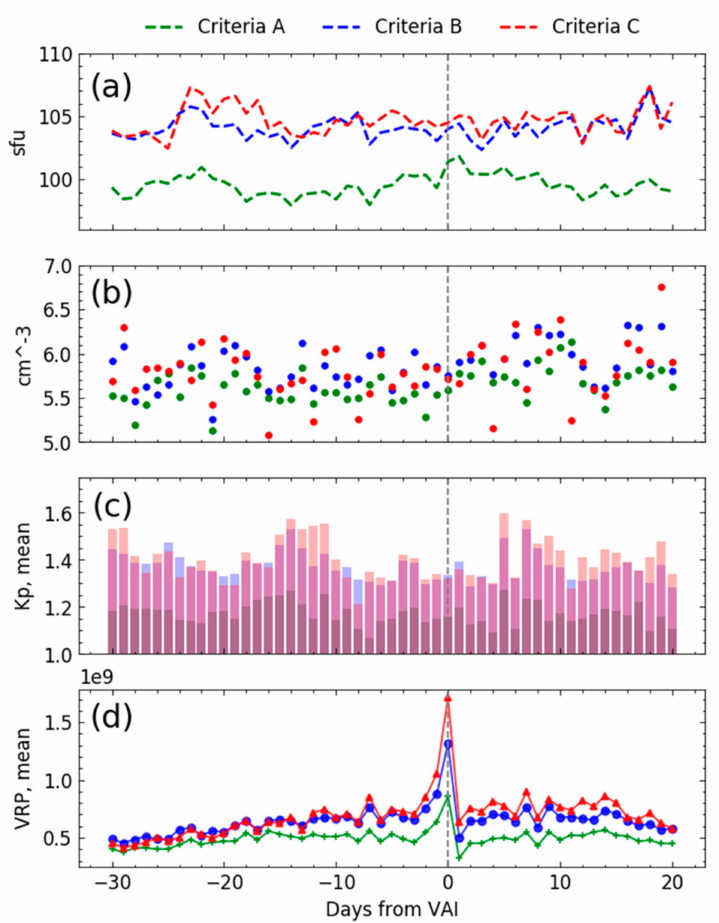
Figure 12. Mean values of 10.7 cm solar flux ( a ), proton density ( b ), Kp index ( c ) and VRP ( d ) during index days for Criteria A (green), B (blue) and C